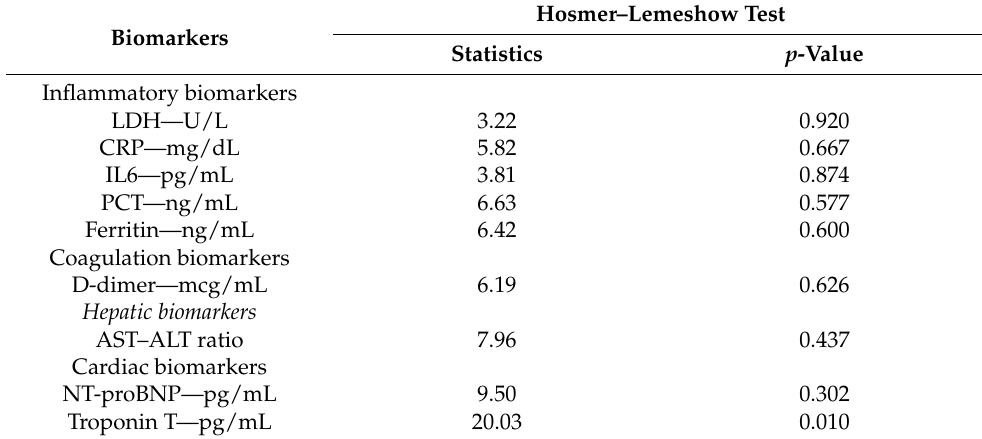
Table 3. Hosmer–Lemeshow goodness-of-fit test of